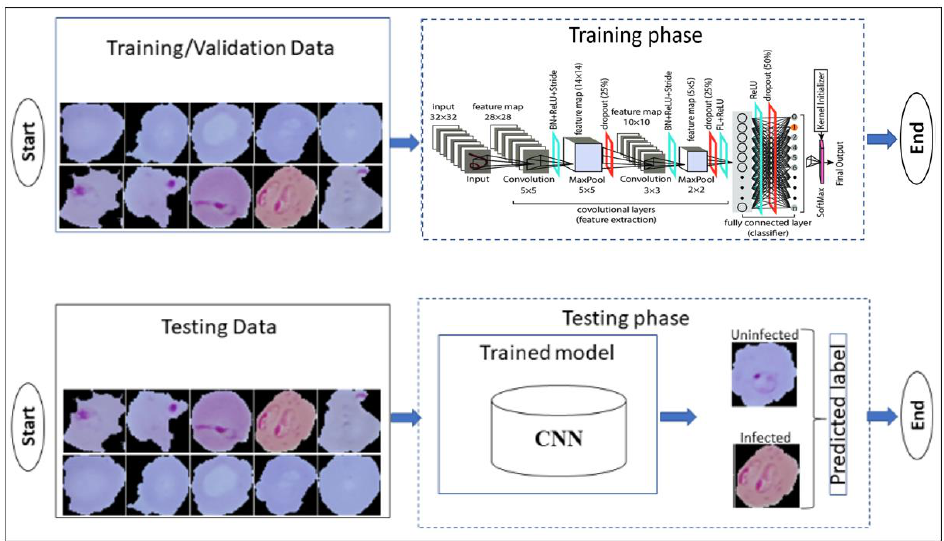
Figure 3. Block diagram of CNN model.